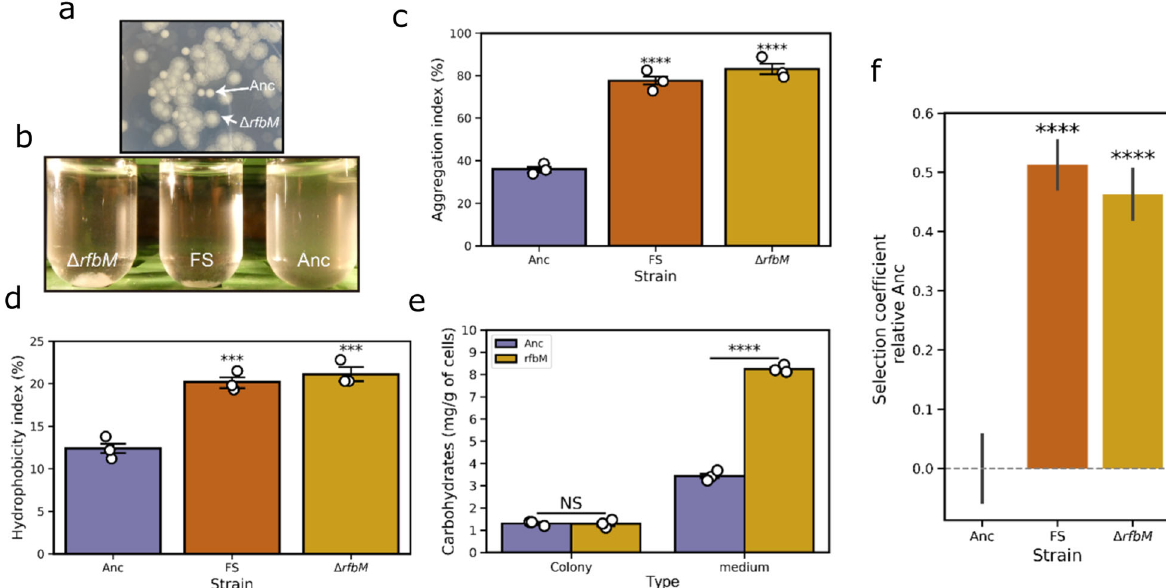
Fig. 6 Phenotypic characterization of the mutant Bt407 Δ rfbM strain compared with the ancestor. a The easily recognizable fuzzy spreader colony morphology by Bt407 Δ rfbM suggests that disruption of the guanylyltransferase coding gene is responsible for the FS morphotype. b Aggregation phenotypes of Bt407 Δ rfbM and FS variant compared with the ancestor. Aggregation ( c ) and hydrophobicity ( d ) index were characterized as described in the materials and methods (*** p < 0.001, **** p < 0.0001; One-way ANOVA followed by Dunnett ’ s multiple comparison tests between the ancestor as control and other groups). e Total carbohydrates determination of Bt407 Δ rfbM and the ancestor. Asterisks indicate signi fi cant differences between each group and the ancestor (**** p < 0.0001; Student ’ s unpaired two-tailed t -test was performed between samples within each condition). Error bars indicate standard error of the mean of independent biological samples ( n = 3). f Fitness of Bt407 Δ rfbM and FS morphotype in a 1:1 competitive experiment against the ancestor. Error bars indicate the standard error of the mean ( n = 6). Asterisks indicate a signi fi cant difference between the tested strains and the ancestor (**** p < 0.0001; Student ’ s unpaired two- tailed t